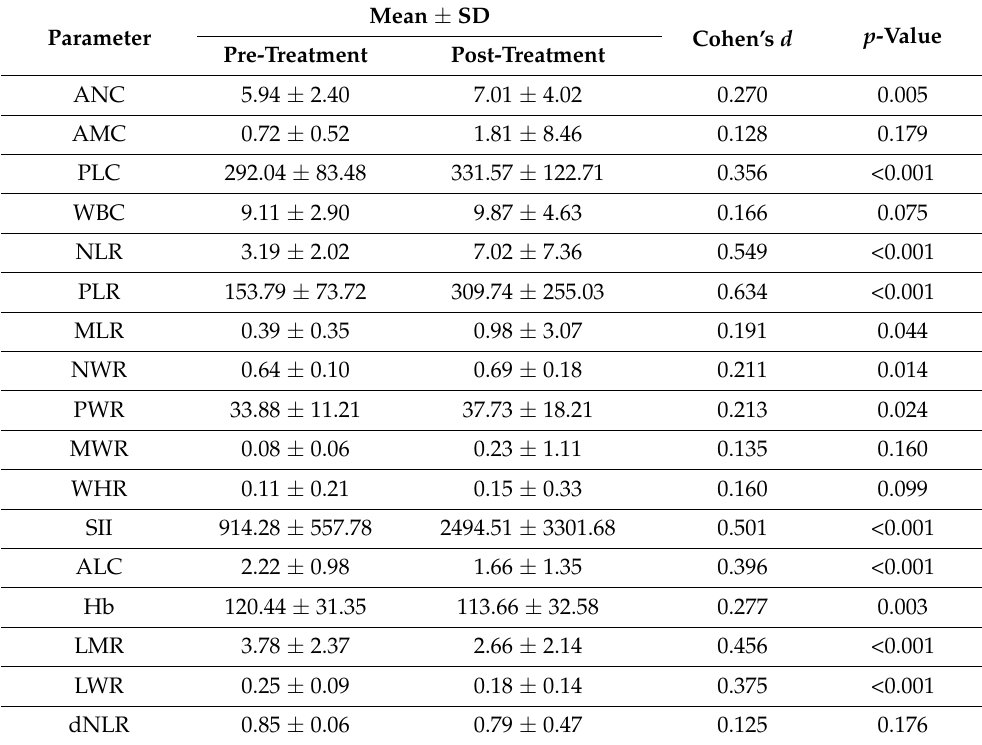
Table 4. Pre- and post-treatment comparison of inflammatory markers studied.